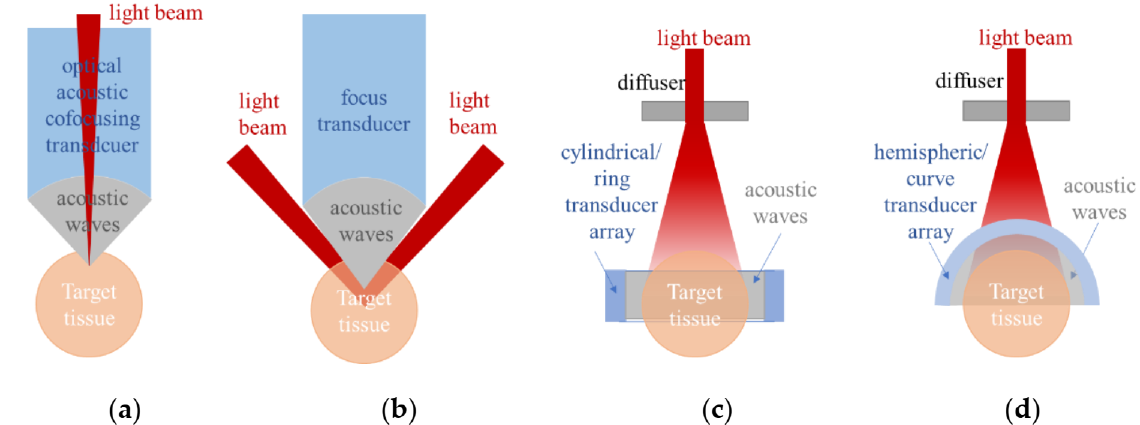
Figure 1. Schemes of PAI techniques for tissue imaging, classified according to spatial resolution and imaging depth: ( a ) OR-PAM, ( b ) AR-PAM and PAMac, ( c , d )